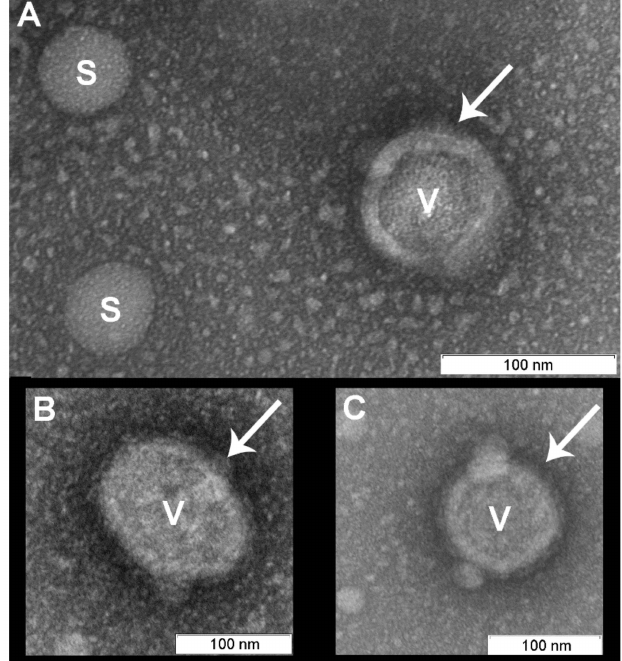
Figure 4. Virions (“V”) irradiated for 20 min with photosensitizer (2 µ M) remained structurally normal with membranes maintaining their structural integrity. The spikes appeared to be absent from the viral membranes, however the “halo” may indicate the presence of glycoproteins (marked with arrows). Spherical vesicles (diameter 30–50 nm, marked “S” ( A ), the similar structures can be recognized on virions surface (B, C)) and grain-like small (5–15 nm) structures were visible and were not observed in the controls. Scale bar 100 nm. The virus suspension inactivated with 4 µ M of photosensitizer contained three forms of “bald” virions: smooth spherical virus particles (~25% of examined virions), virions with partially destroyed membranes (“dark windows”, ~60%), and completely (deformed, disintegrated particles, ~15%) destroyed membranes (Figures 5 and 6). These forms seem to reflect the degree of virion damage and may be associated with both irradiation fluctuations and the heterogeneity of virions with respect to photosensitizer binding. Long periods of irradiation with high concentrations of photosensitizer destroyed all virions as shown in other studies [21].